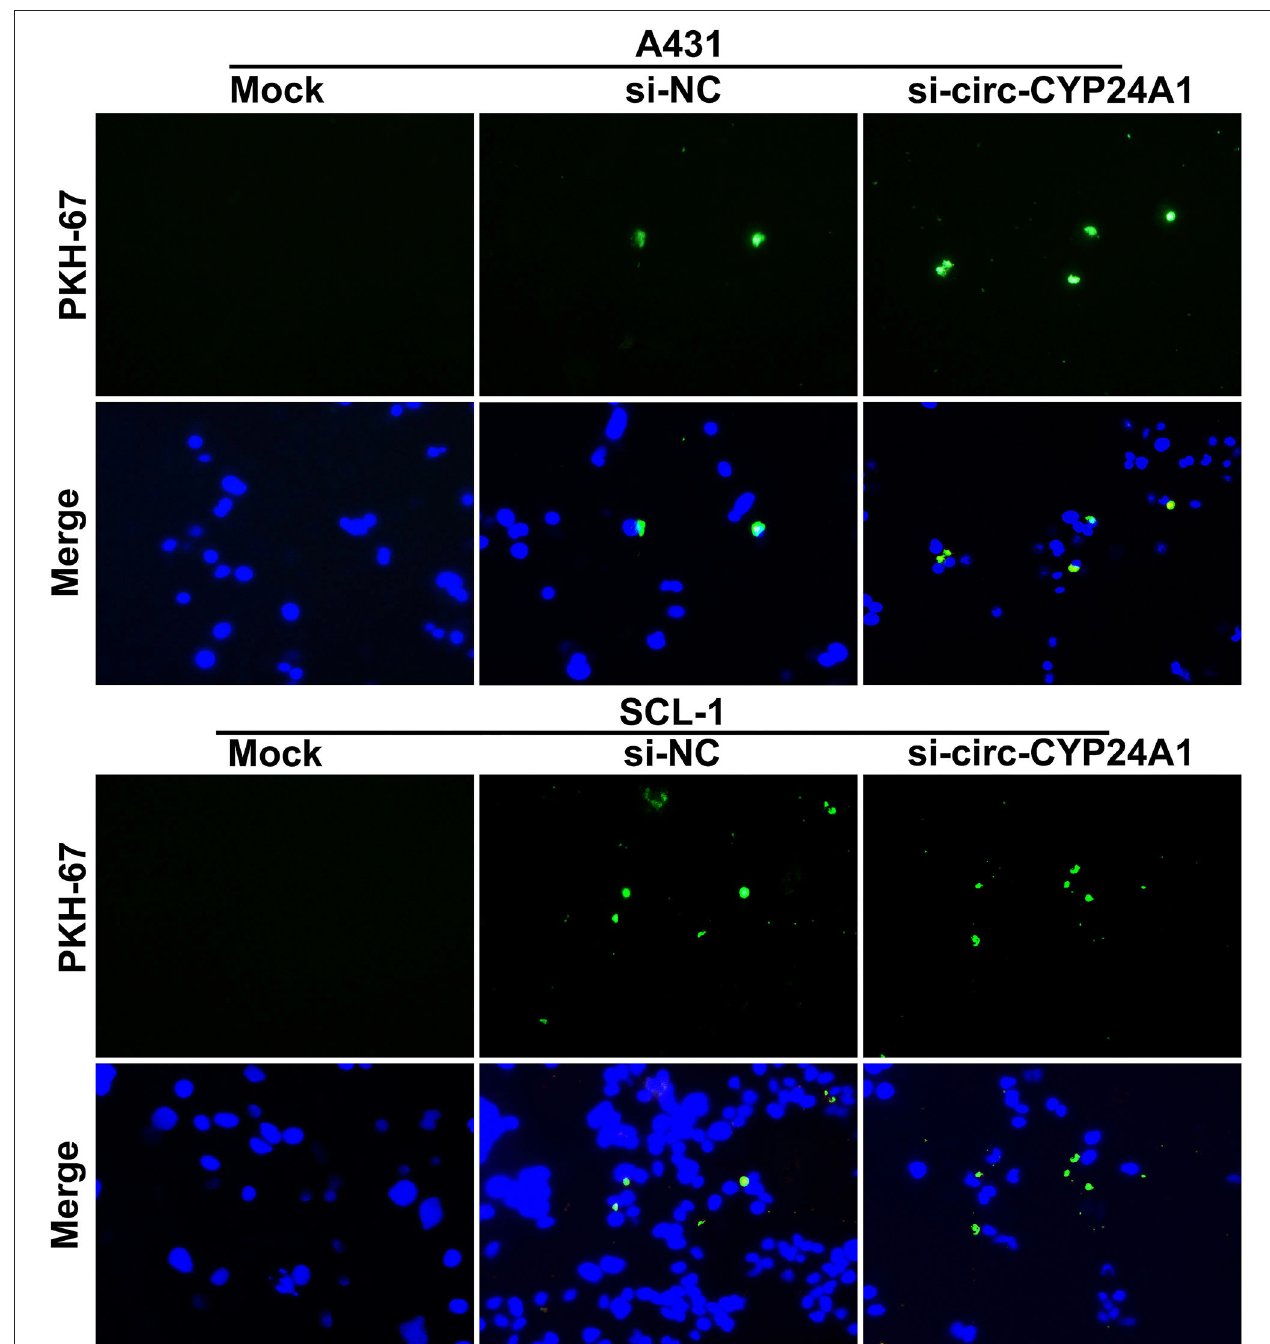
FIGURE 6 | A tracer experiment for observing the uptake of exosomes carrying circ-CYP24A1 by A431 and SCL-1 cells.